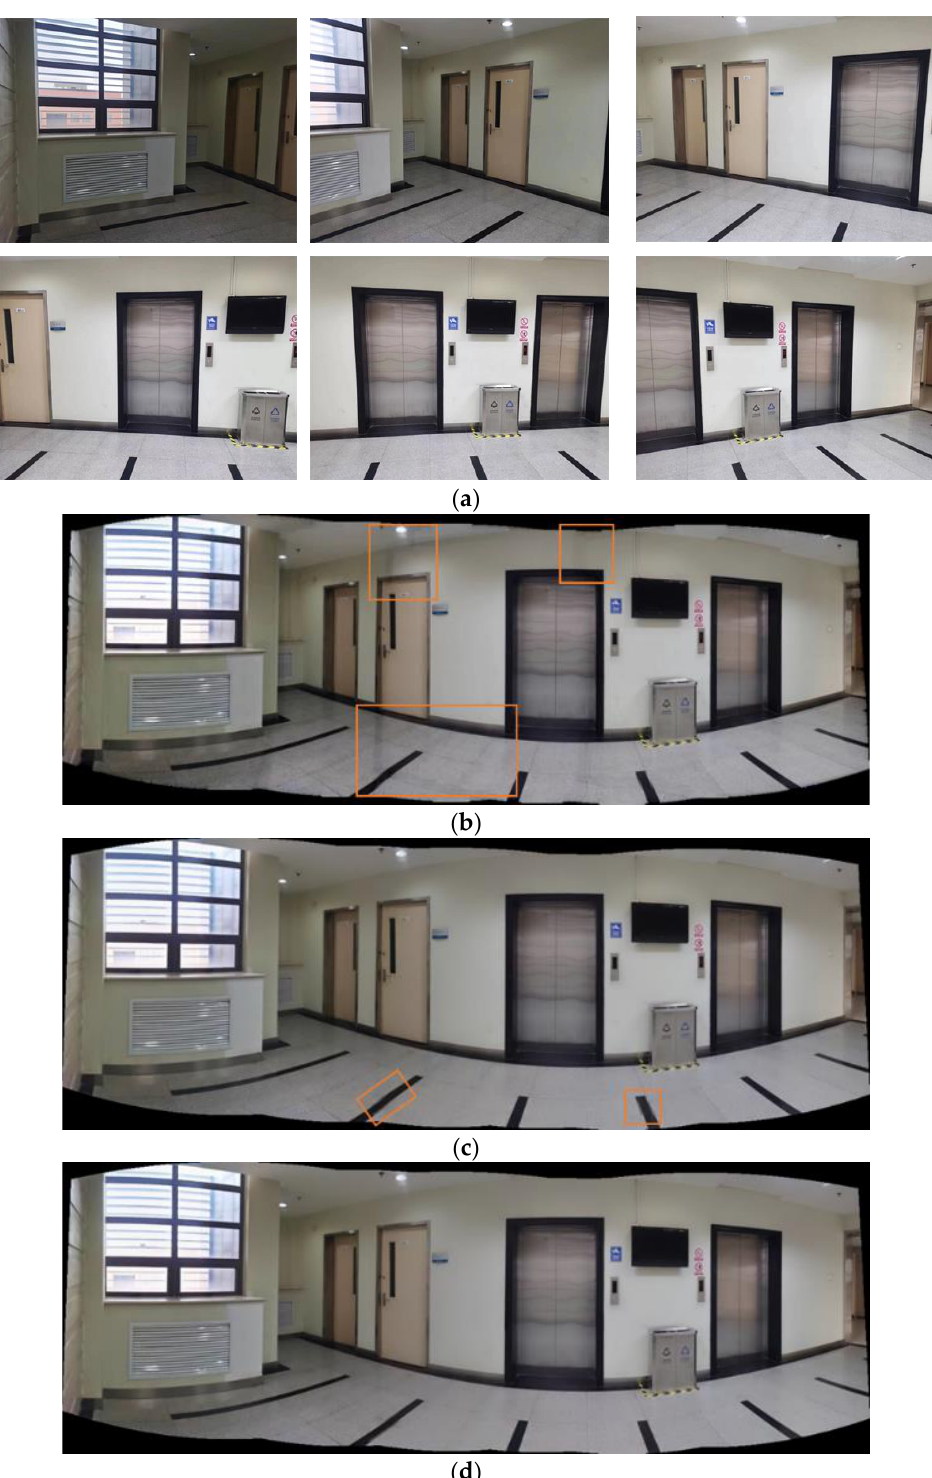
Figure 14. Indoor images: ( a ) input images; ( b ) panorama by optimal seam + fade-in and fade-out weighted method; ( c ) panorama by optimal seam + multi-resolution method; ( d ) panorama by the proposed method.